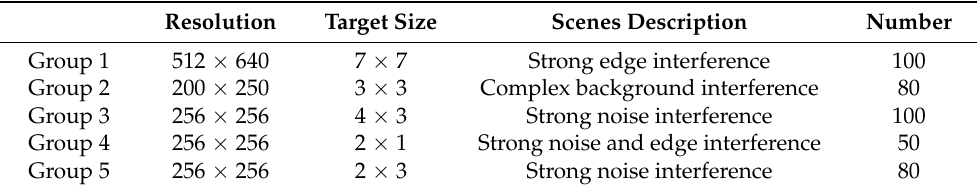
Table 1. Five sets of infrared image sequence dataset